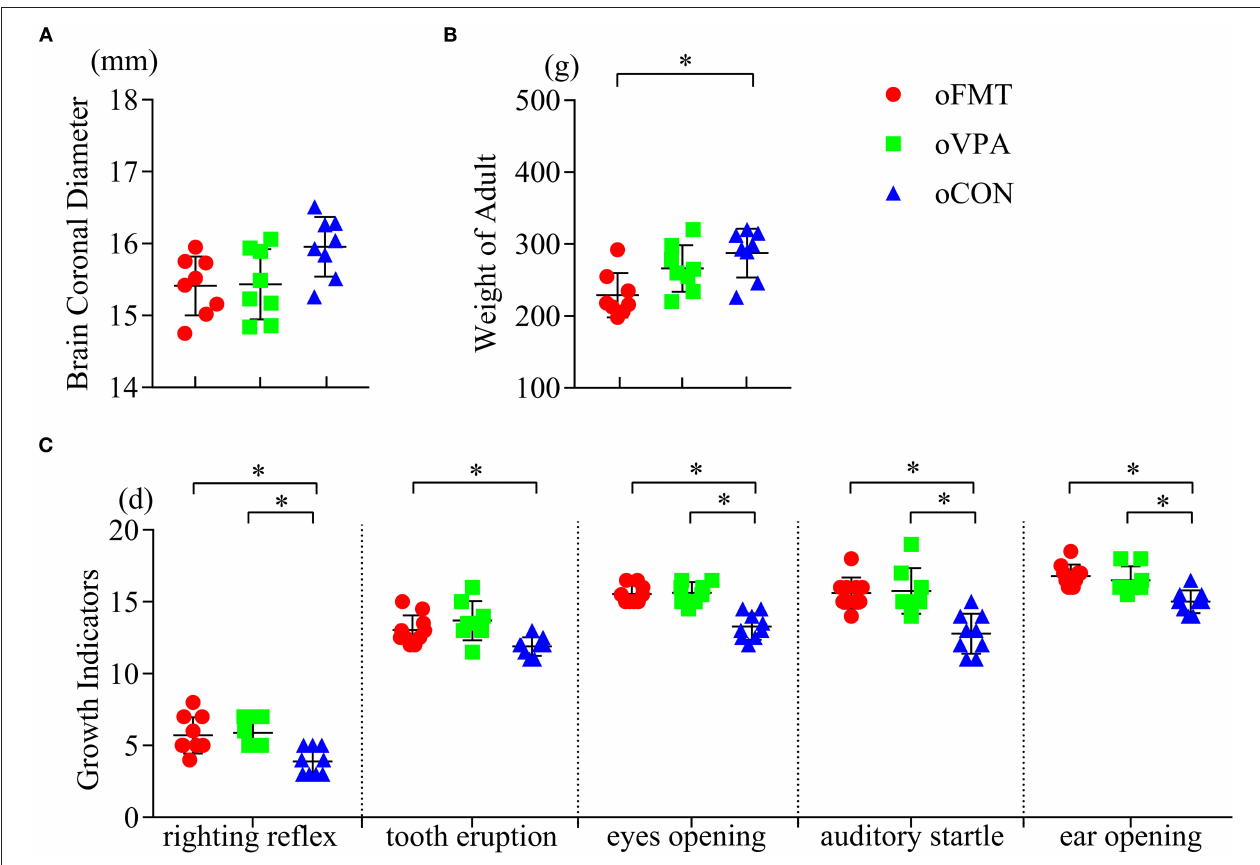
FIGURE 1 | Impact of fecal microbiota transplantation (FMT) on growth and development phenotypes and indicators in offspring rats. The fecal microbiota transplantation group (oFMT) “* P < 0.05” compared with the control group (oCON). (red dot: oFMT; green squares: oVPA; blue triangle: oCON). (A) Brain coronal diameter of rats ( n = 8, each group). (B) Bodyweight of adult rats ( n = 8, each group). (C) Growth and development indicators for eye-opening, ear-opening, tooth eruption, auditory startle, and righting reflex (oFMT, n = 10; oVPA, n = 8; oCON, n = 9) (The data were collected from all rats in each litter, then obtain the average value of each litter data. Finally, bring the average value into statistical